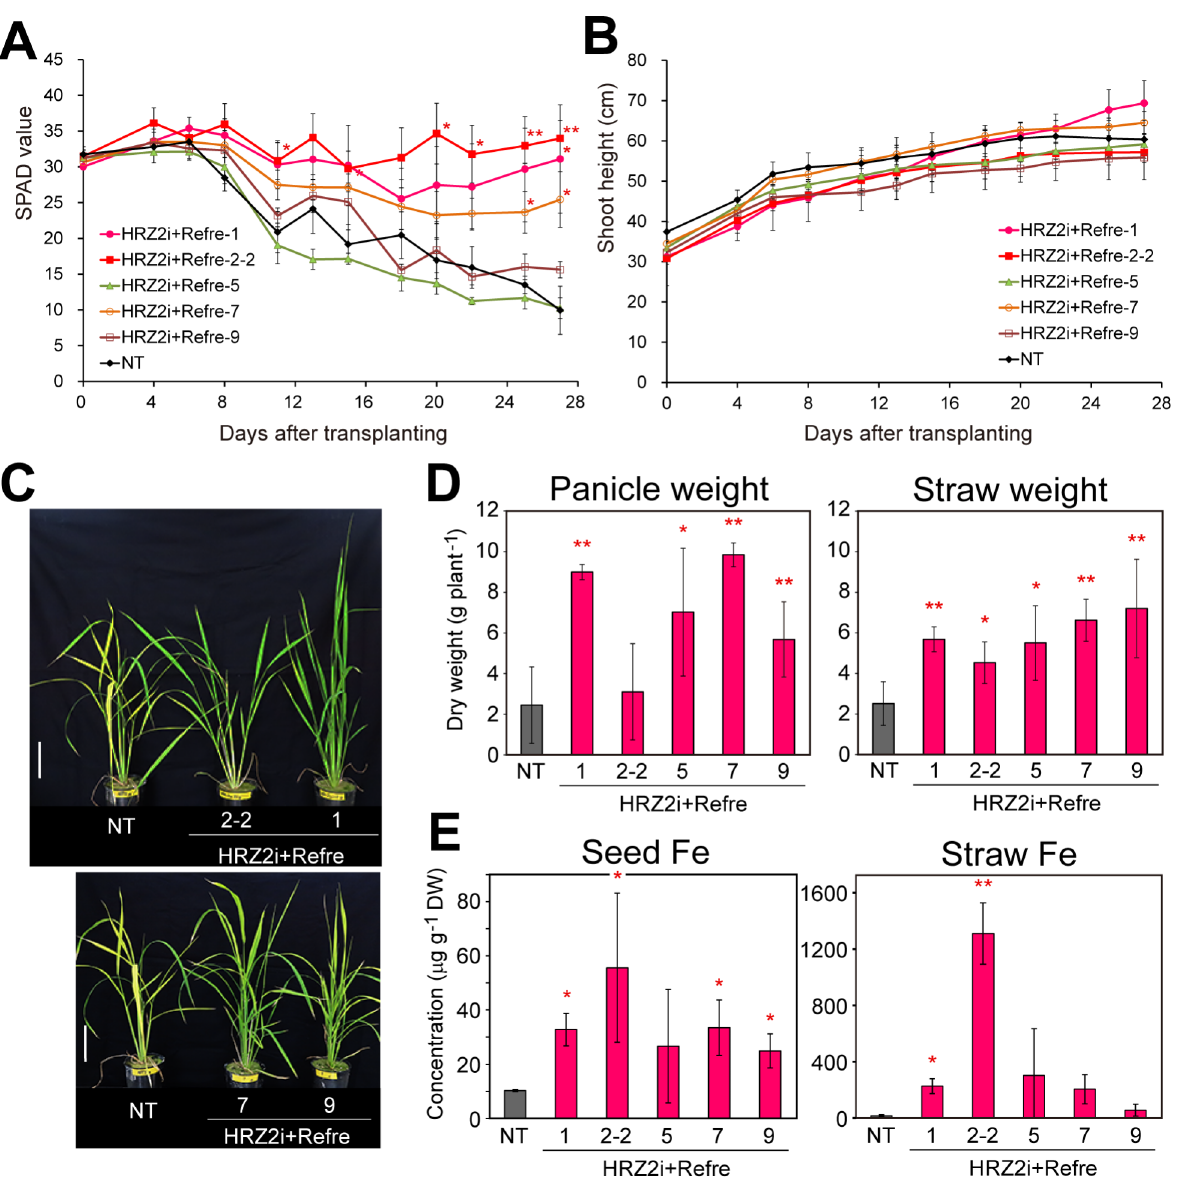
Fig. 3 Features of the HRZ2i + Refre lines under pot cultivation in calcareous soil with non-submerged conditions. A The Soil Plant Analysis Develop- ment (SPAD) value of the newest leaves. B Shoot height. C Representative plants on day 29 after transplanting. Scale bar = 10 cm. D Panicle and straw dry weights after seed maturation. E Fe concentrations in brown seeds and straw following seed maturation. The following lines were cultivated: NT, non-transformants; HRZ2i + Refre, T 1 lines of 1, 5, 7, and 9, and T 2 line of 2–2. DW: dry weight. For A and B , the means ± standard error (SE) are shown (n = 4). Asterisks indicate significant differences compared to the NT at each time point (two-sample Student’s t -test; * P < 0.05; ** P < 0.01). For D and E , the means ± SD are shown (n = 4 for all groups in D and HRZ2i + Refre lines 2–2, 5, 7, and 9 for seed Fe; n = 2 for NT for seed Fe; and n = 3 for HRZ2i + Refre line 1 for seed Fe and all lines for straw Fe). Asterisks indicate significant differences compared to the NT (two-sample Student’s t -test; * P < 0.05; ** P <